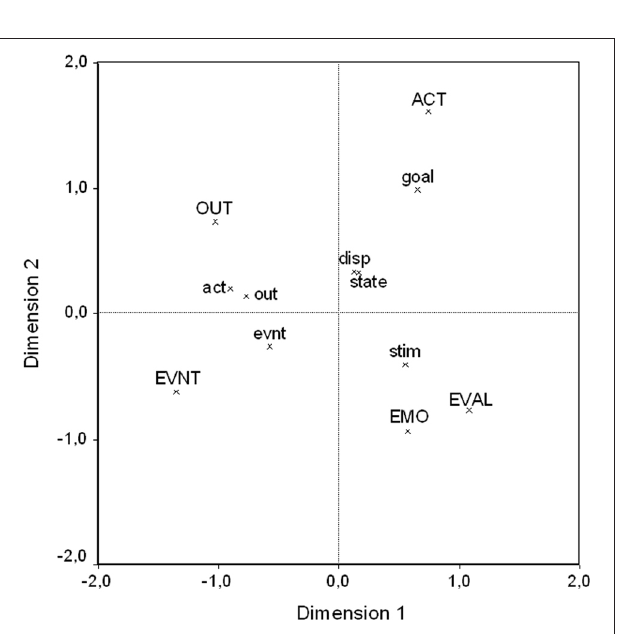
FIGURE 3 | Asymmetric correspondence analysis plot of free-response explanations, Experiment 1. Behavior types are in standard coordinates, explanation types in principal coordinates. Percentage of inertia: Dimension 1 = 50.43%, Dimension 2 = 26.65%. Behavior Types are depicted in